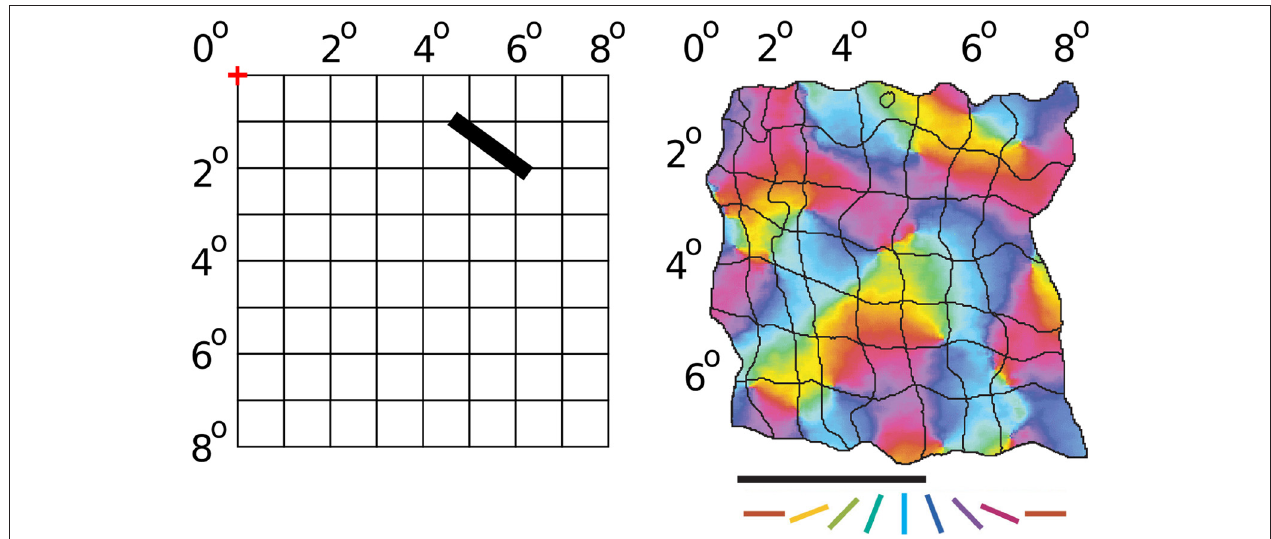
specifi c neurons respond within that general area, however, depends on the orientation of the stimulus. The V1 map is color coded with the preferred orientation of neurons in each location; e.g. the black bar shown at left will primarily activate neurons colored in purple in the corresponding V1 grid squares. Similar maps could be plotted for this same area showing preference for other visual features, such as motion direction, spatial frequency, color, disparity, and eye preference (depending on species). Other cortical areas are arranged into topographic maps for other sensory modalities, such as touch and audition, and for motor outputs. Topographica is designed to simulate any of these cortical or subcortical